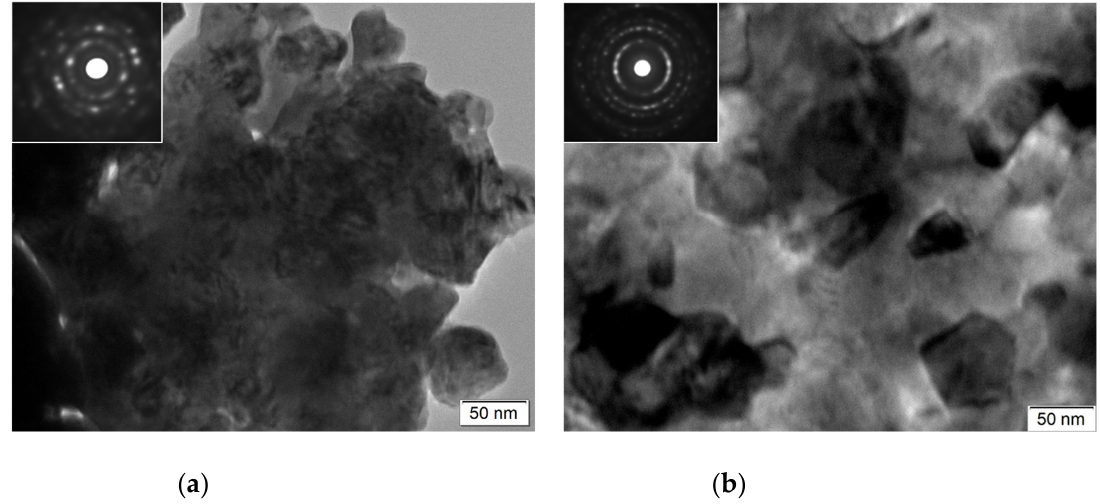
Figure 6. TEM microstructure and corresponding SAD patterns of ( a ) N5 and ( b ) P4.